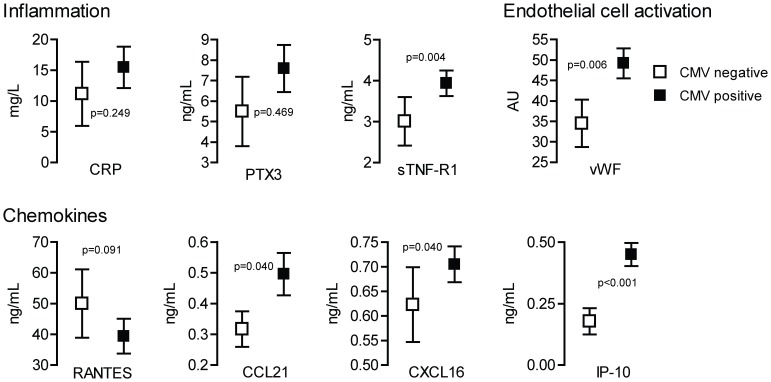
Markers of inflammation in relation to CMV-DNAemia.Plasma levels of markers of inflammation, marker of endothelial cell activation and chemokines in relation to presence or absence of CMV DNAemia in patients suspected to have CMV disease. The P-values are adjusted for potential confounders (i.e., age, sex and time from transplantation). P-values <0.00625 were considered significant to account for multiple testing (see Methods). Data are given as mean and 95% CI.